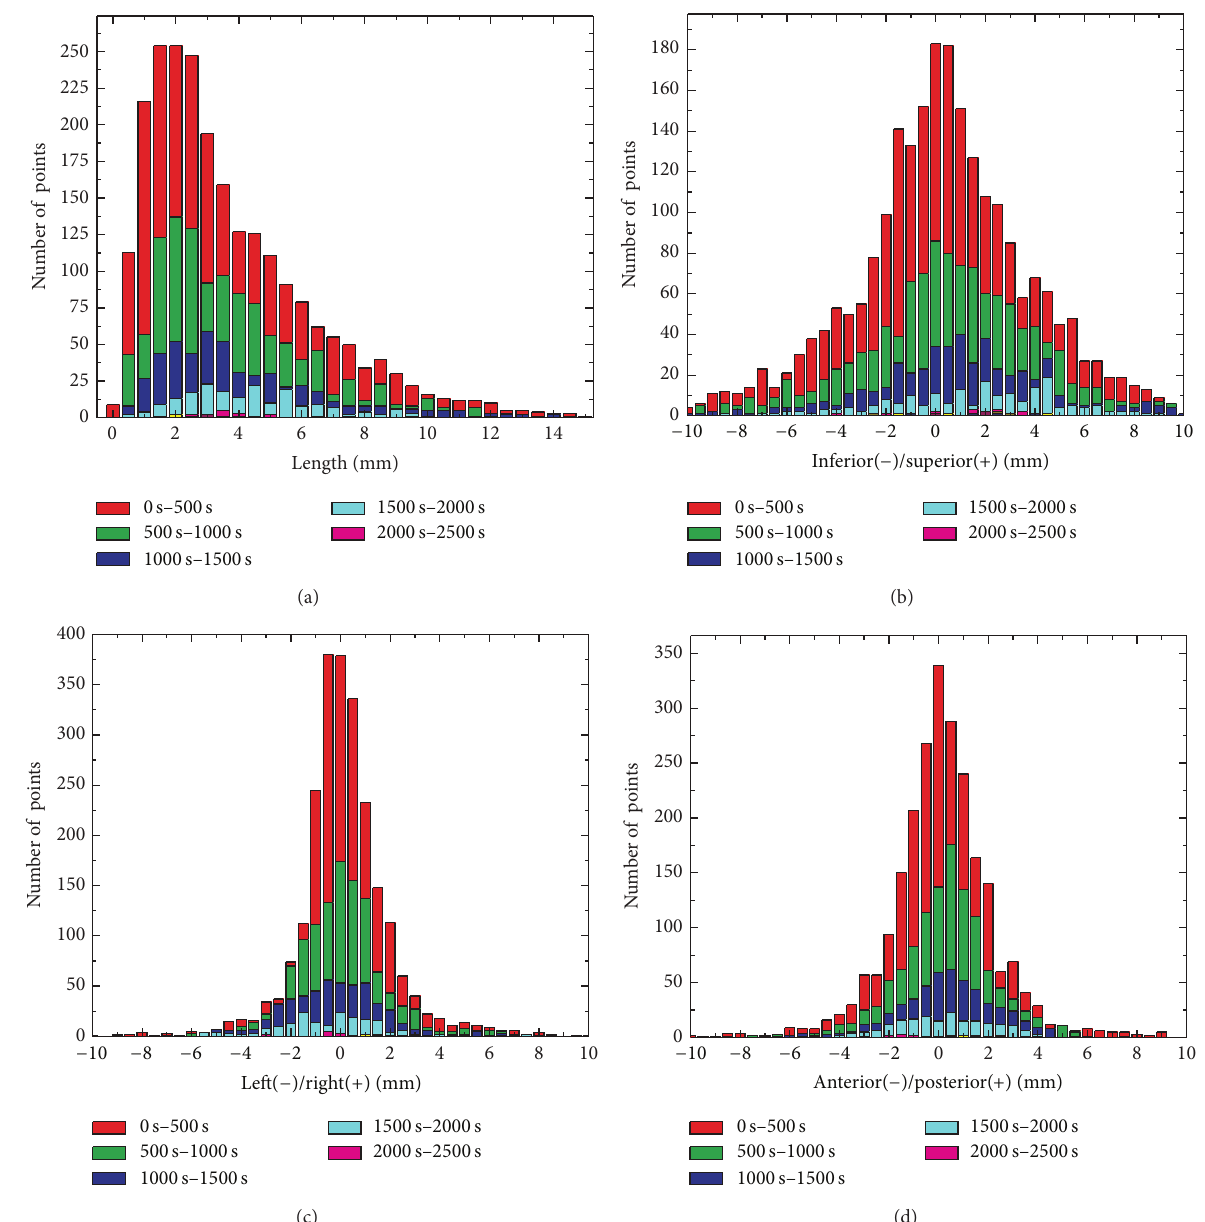
Figure 4: Histogram of the pancreas movement as a function of displacement and